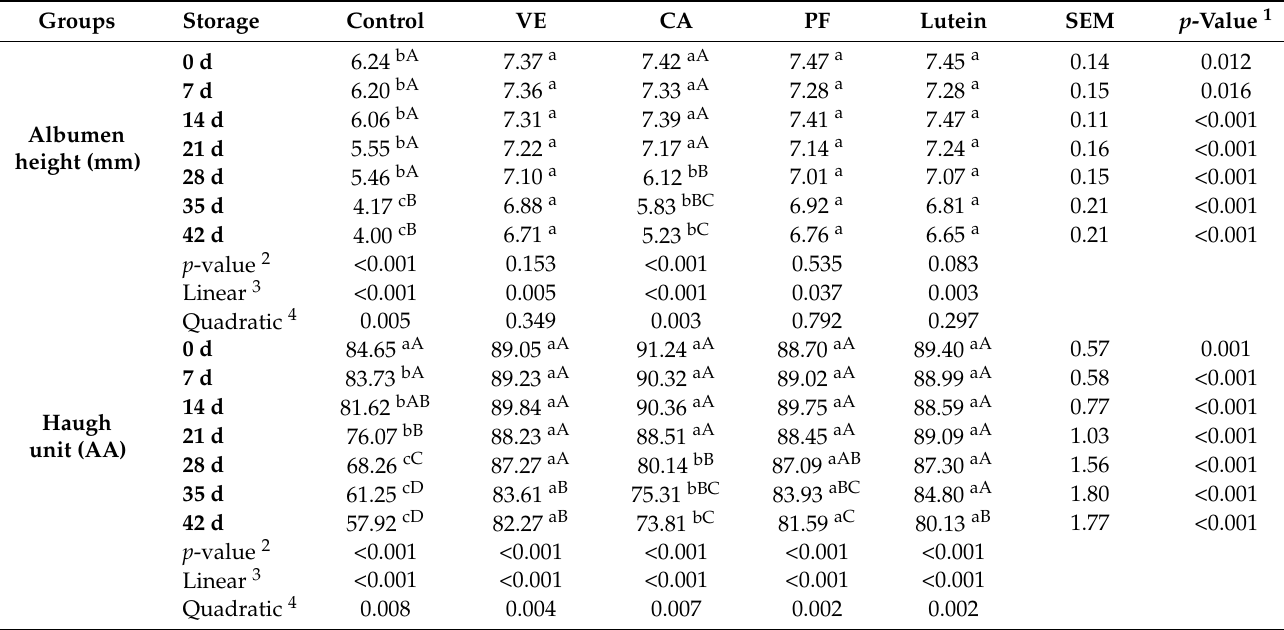
Table 4. The effect of different antioxidants on the egg quality during